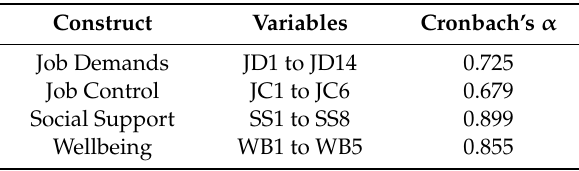
Table 3. Internal